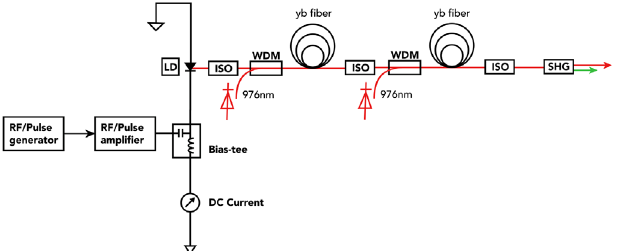
FIG. 4. Schematic of the rf-pulsed green-light driver laser system (LD, laser diode; ISO, optical isolator; WDM, wavelength division multiplexer; SHG, second harmonic generation